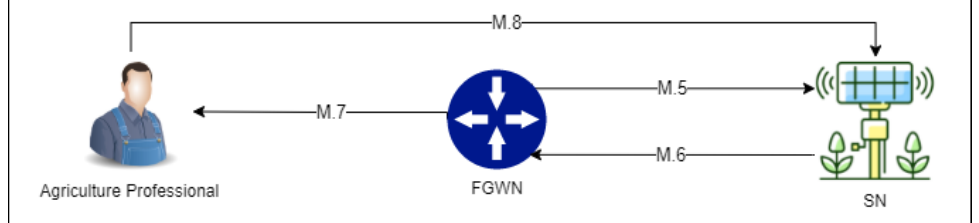
Figure 10. Authentication phase (Case